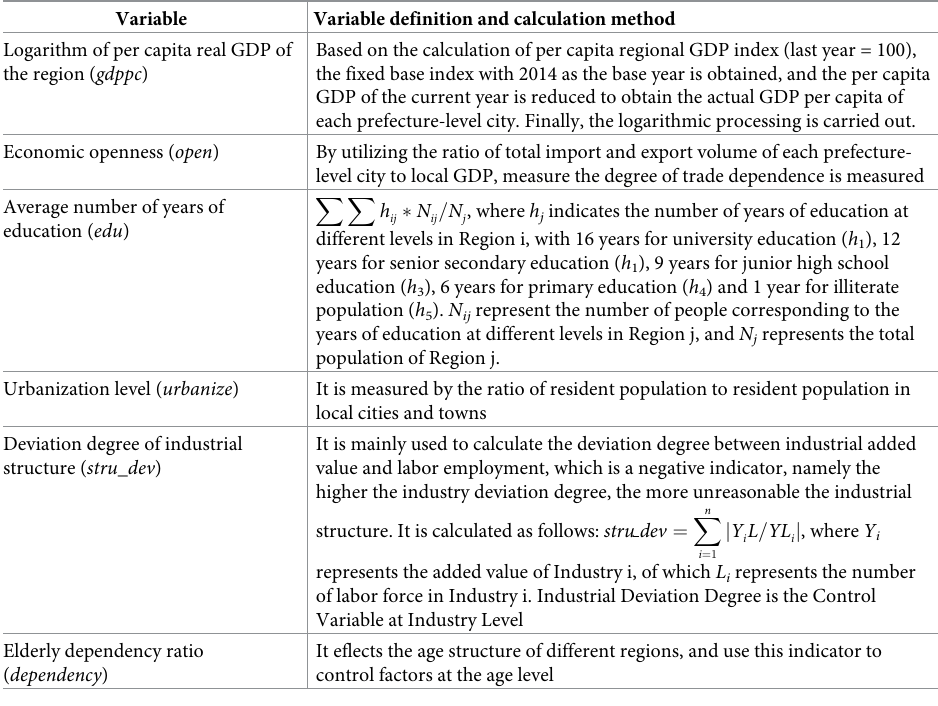
Table 2. Control variables and their explanations. Variable Variable definition and calculation